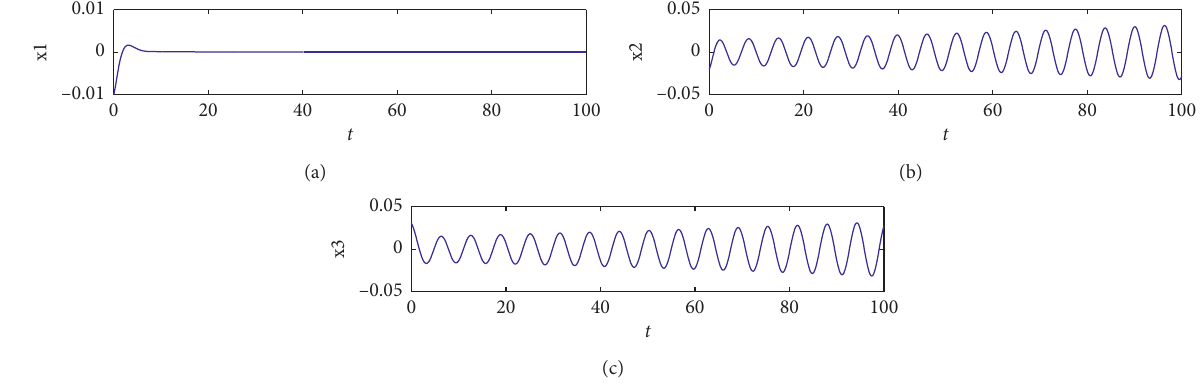
Figure 6: System (34) is unstable with α �